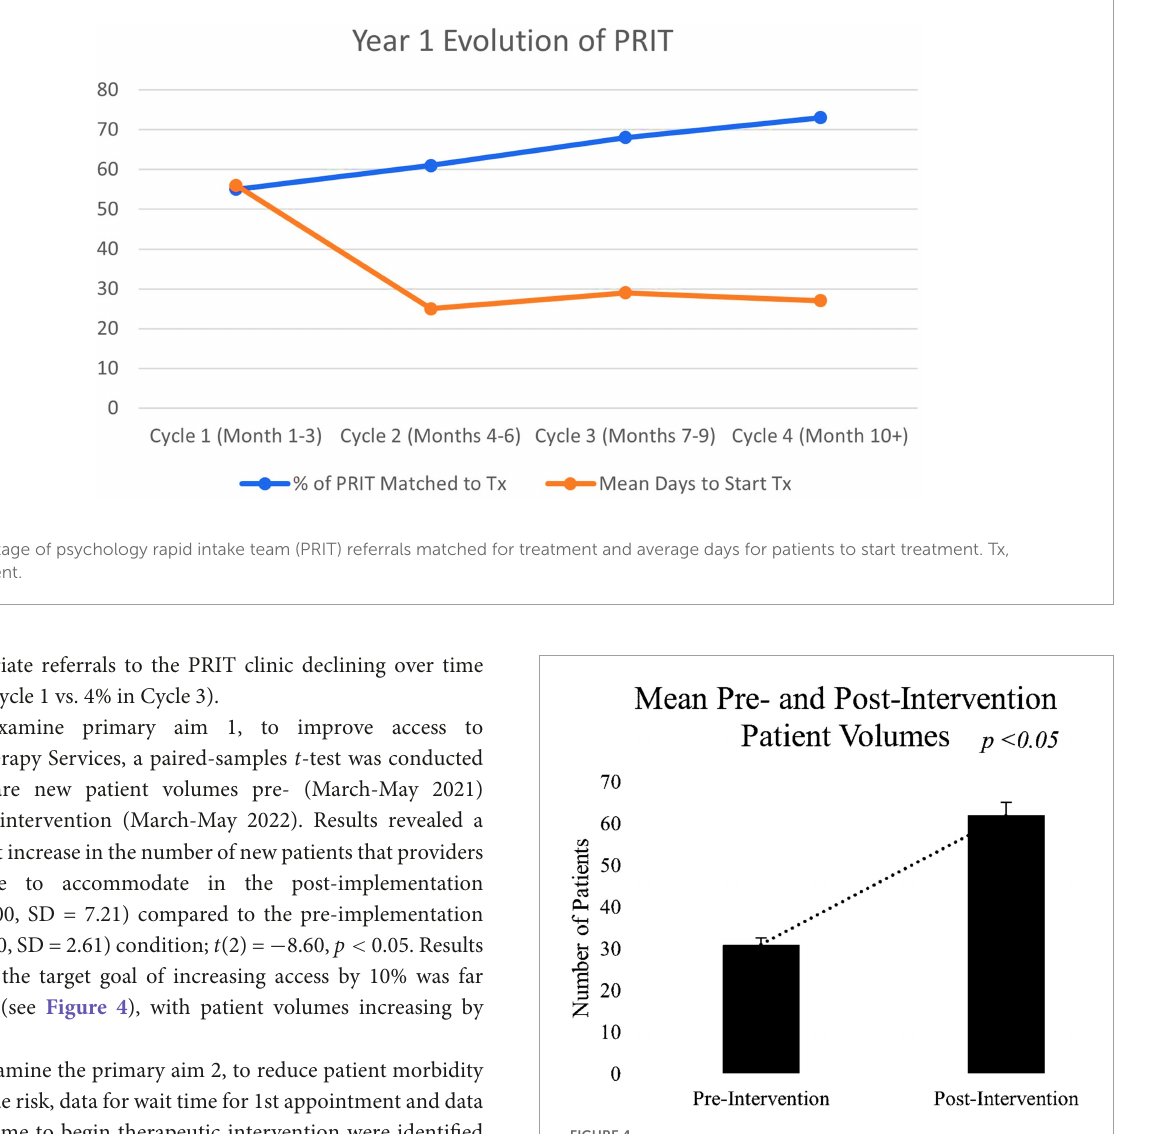
FIGURE4 Number of new patients that providers accommodated in pre-and